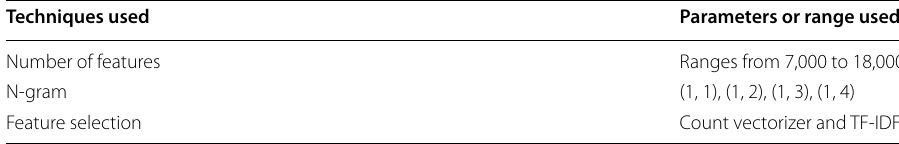
Table 3 Techniques used as brute-force algorithms in each attempt for all algorithms Techniques used